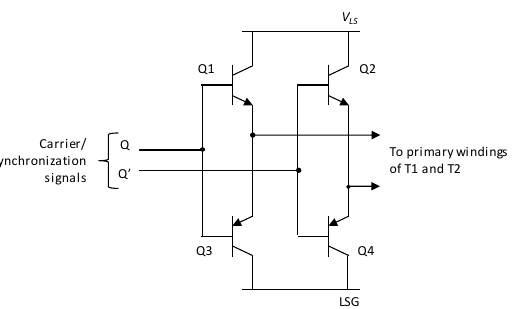
Figure 10. Full-bridge circuit used for driving transformers T1 and T2 in Figure 8. The complementary signals Q and Q (cid:48) driving the emitter-follower legs are derived from the same oscillator producing the carrier-frequency signal used for transmitting the gate drive signals in Figure 7.